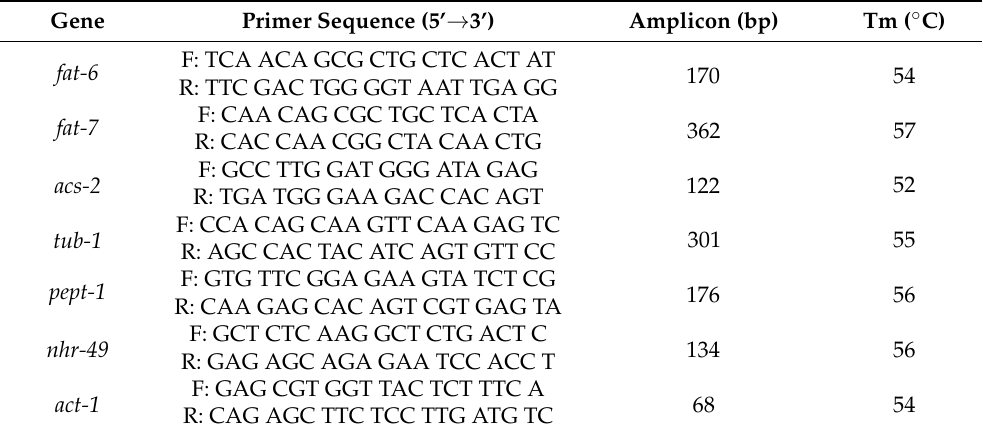
Table 2. Primers used for PCR and